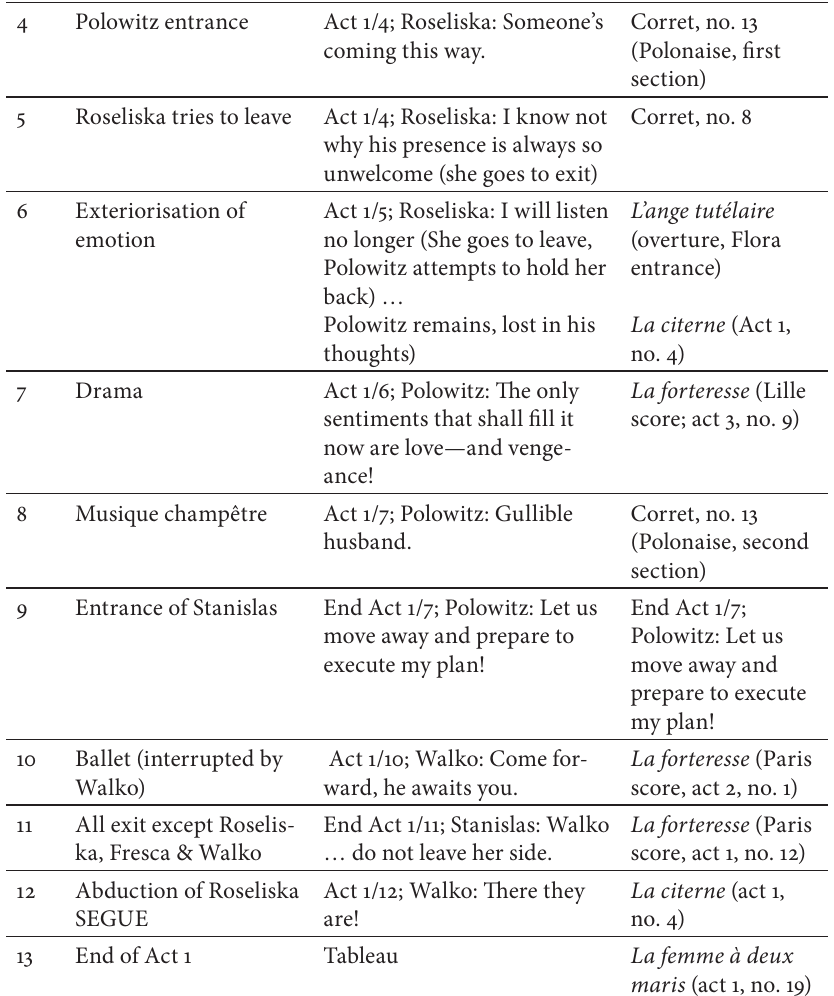
Fig. 1 Cues and musical sources: Roseliska, act